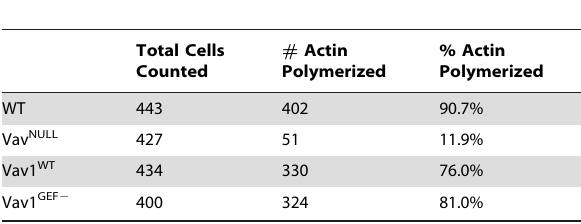
Table 1. TCR-induced F-actin polymerization in T cells activated on stimulatory coverslips.